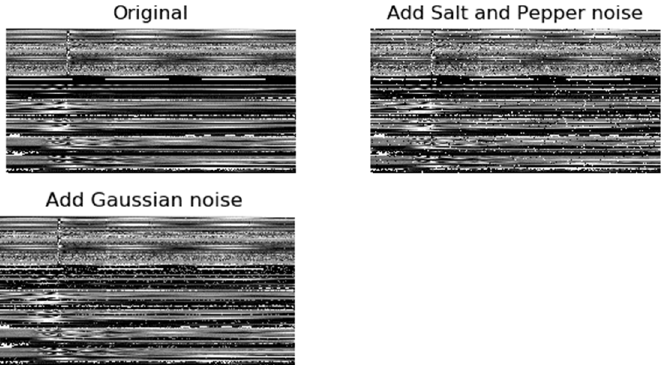
Figure 18. The data set is superimposed with salt and pepper noise or Gaussian noise. Table 7. Comparison of the final classification effect of adding noise to the data